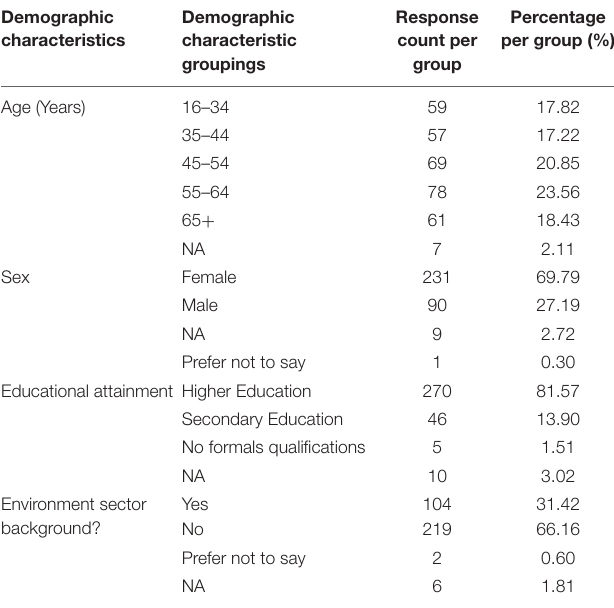
TABLE 1 | Demographic characteristics of survey respondents ( n = 331), showing the characteristic groupings analysed in the survey. Demographic